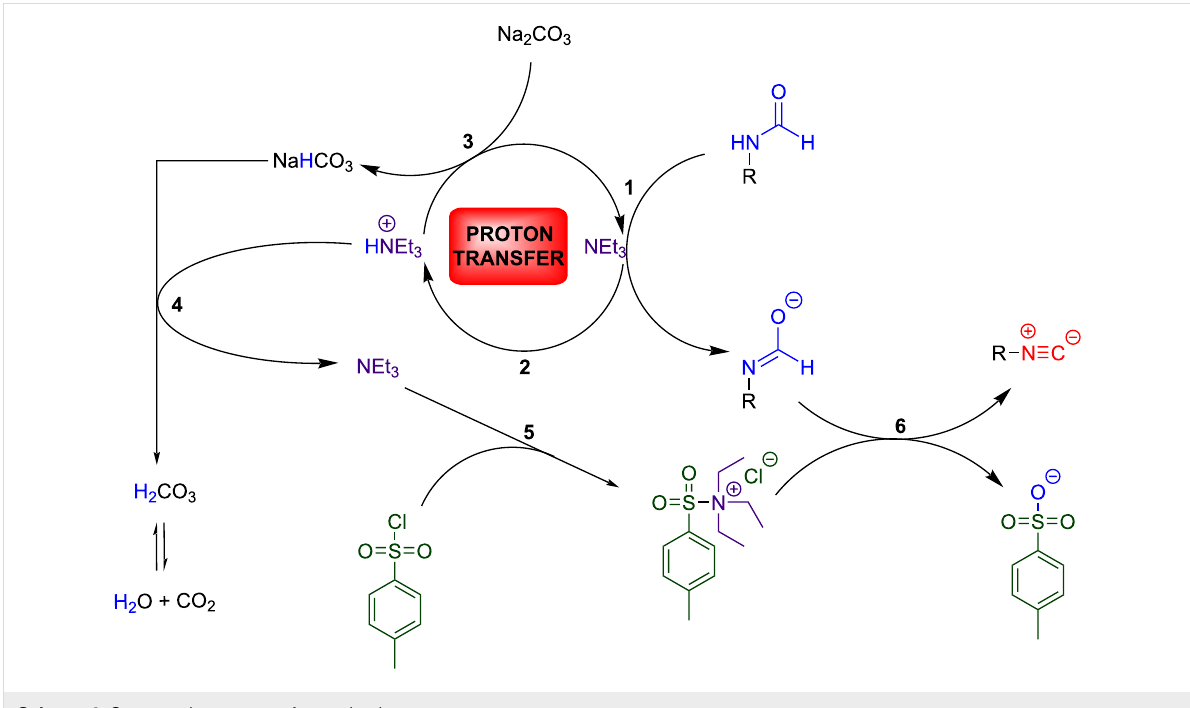
Scheme 4: Suggested proton transfer mechanism.